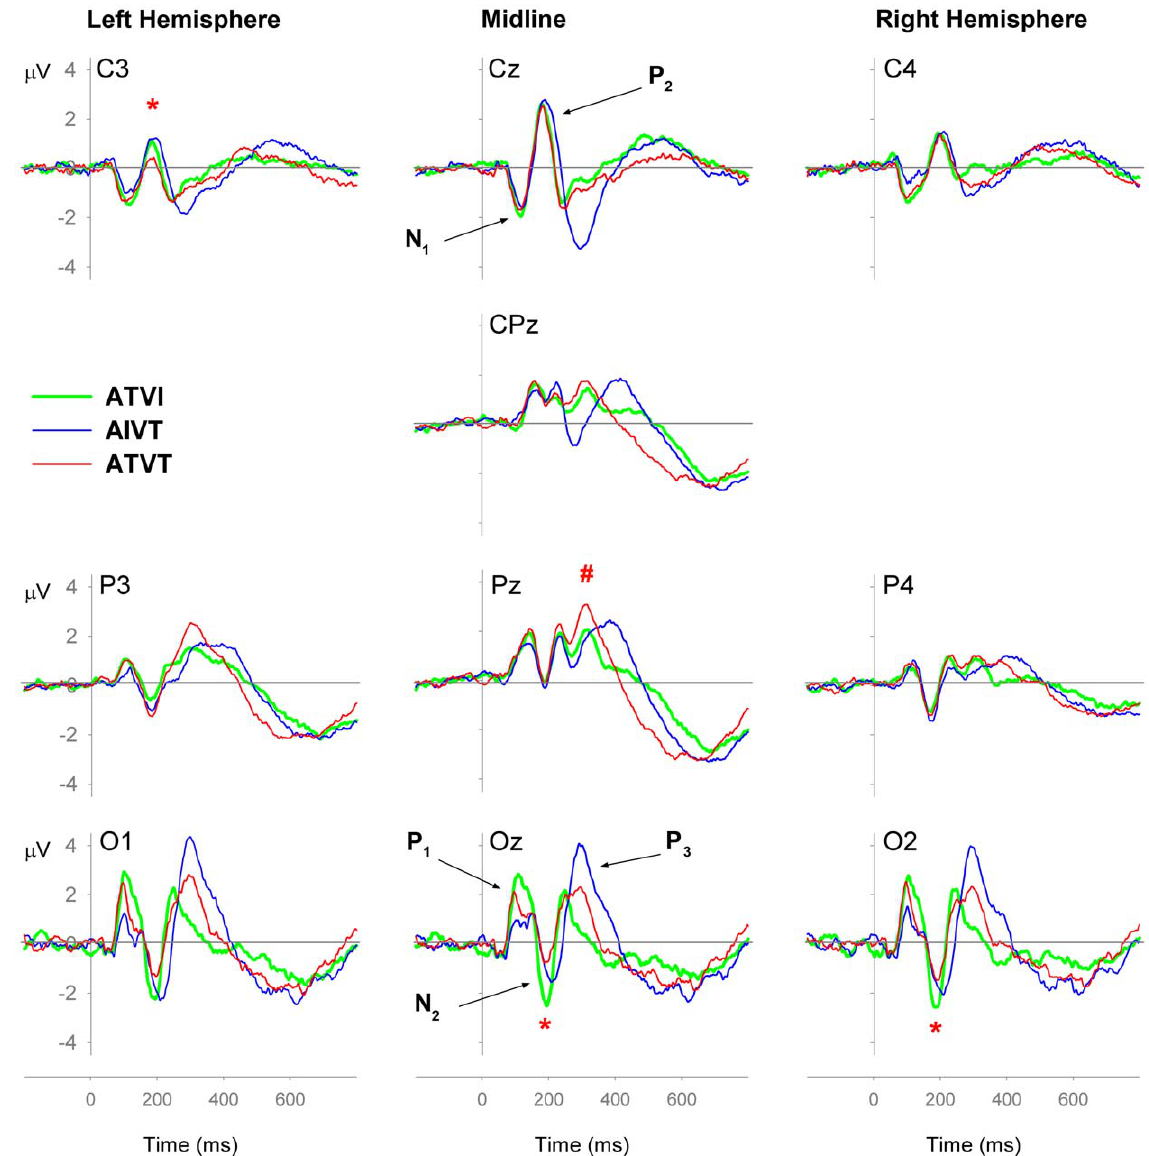
Figure 2. Event-related potentials (ERPs) for audiovisual stimuli with irrelevant components and dual targets. ERPs for the audiovisual stimuli ATVI (auditory target and visual irrelevant), AIVT (auditory irrelevant and visual target) and ATVT (audiovisual dual targets) at central (C3 Cz, C4 and CPz), occipital (O1, Oz and O2) and parietal (P3, Pz and P4) electrode sites. * depicts post-hoc outcomes following a significant interaction effect for voltage difference where ATVT is significantly different from both ATVI and AIVT. # depicts a significant main effect for stimulus type where ATVT is significantly different from both ATVI and AIVT.